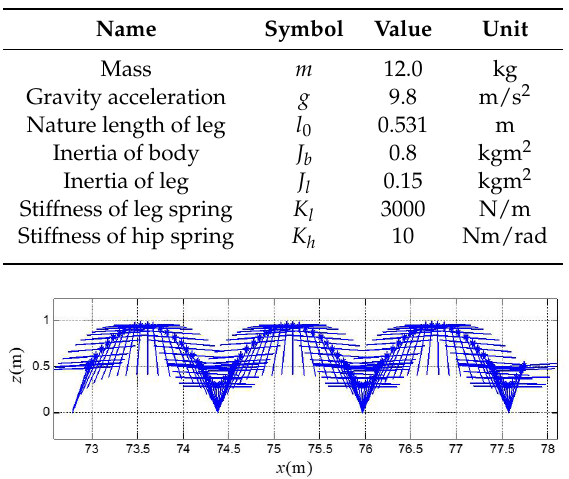
Figure 6. Animations of the one-legged robots in hooping with locomotion speed about 2 m/s.